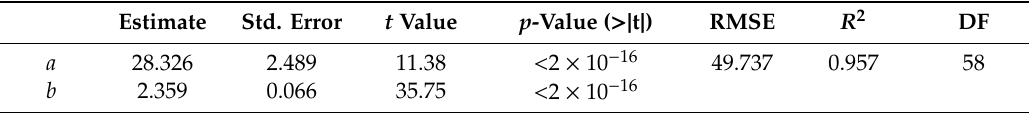
Table A1. Parameter estimates and goodness-of-fit statistics for the poplar shoots model with the equation DW sh = b × D c .